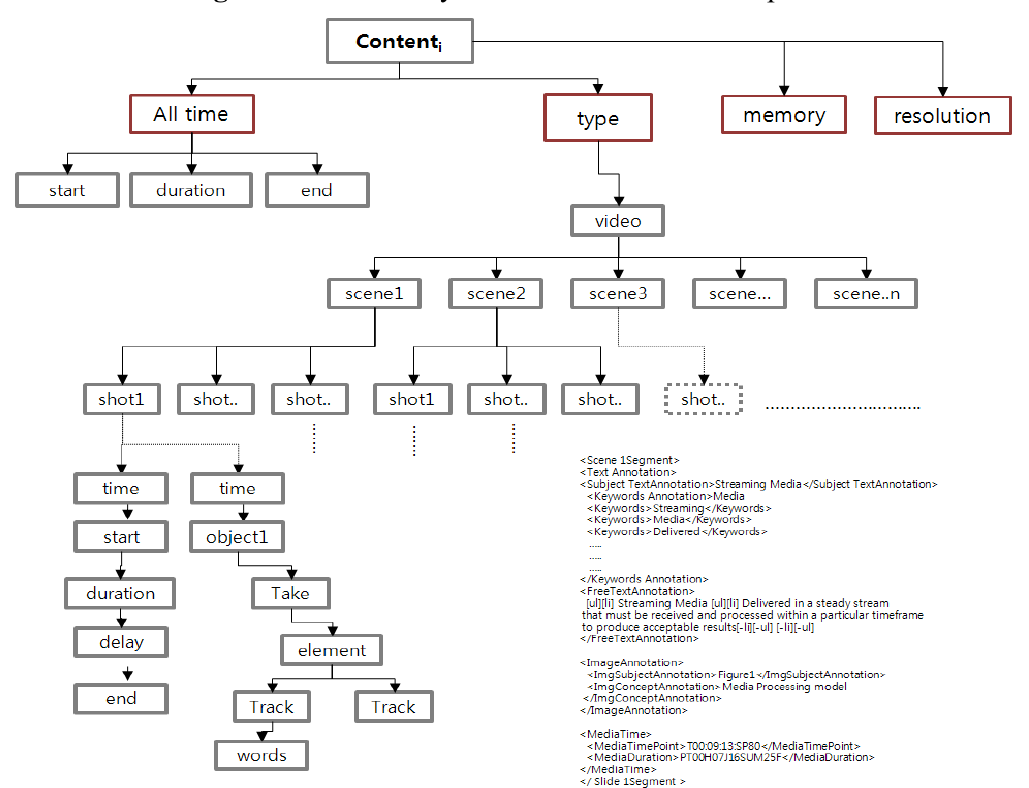
Figure 5. Video analysis based Semantic